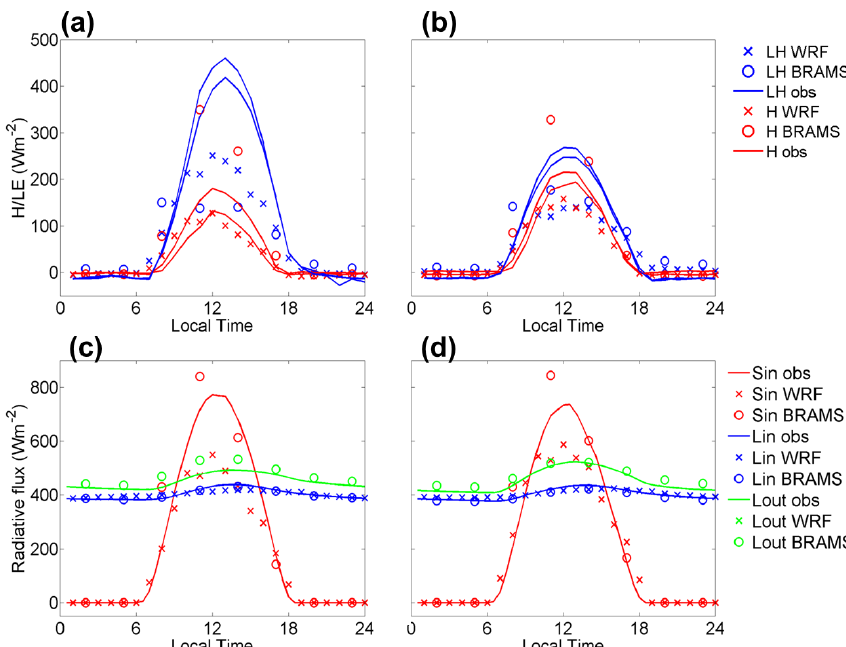
Figure 6. Mean daily cycles of surface (a) latent (LE) and sensible (H) heat and (c) incident shortwave (S in ) and incoming (L in ) and outgoing (L out ) longwave radiation fluxes for a forest site and (b) heat and (d) radiation fluxes for a pasture site, comparing observations (solid lines) from von Randow et al. (2004) for the dry-to-wet transition season (July–September 1999–2000) and from WRF-Chem (crosses) and CCATT-BRAMS (circles) for the BARCA A period (October–November 2008).